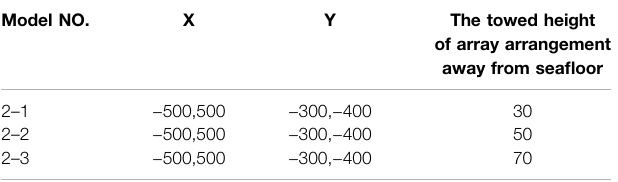
TABLE 3 | The model parameters of the various towed heights of the array arrangement away from the sea fl oor that need to be compared in this group. Model